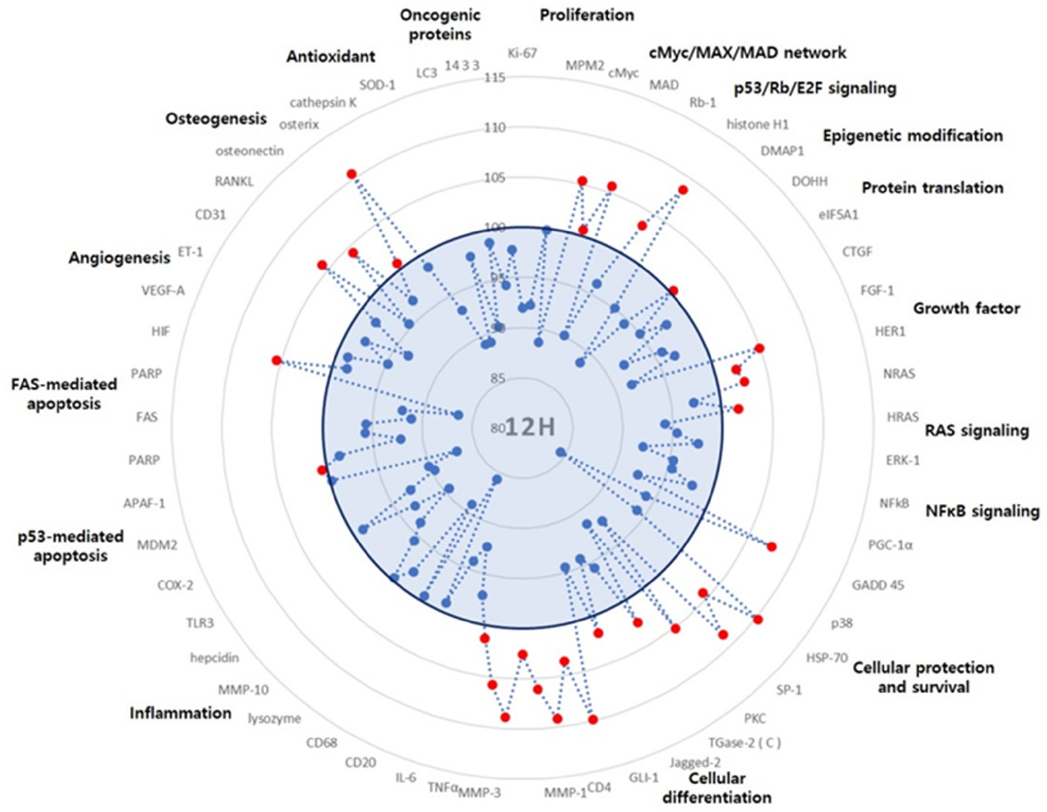
Figure 9. Global protein expression diagrams showing the effects of PTX on RAW 264.7 cells after 12 h treatment. Up-regulated (red dots) and down-regulated (blue dots) proteins are displayed in this diagram. PTX down-regulated the proliferation-, apoptosis-, inflammation-, oncogenic-related proteins and up-regulated the osteogenesis-related proteins. Table 2. Representative cellular signaling affected by Pentoxifylline in RAW 264.7 cells.